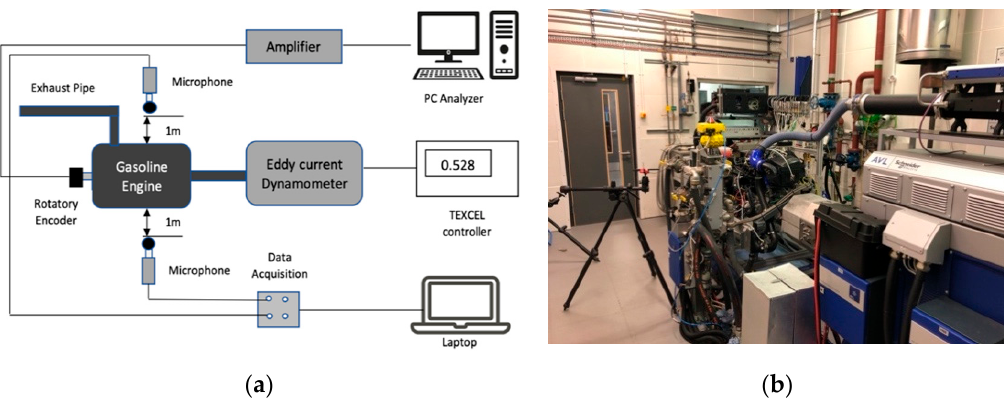
Figure 1. ( a ) Schematic of the set-up; and ( b ) the instrumented engine.